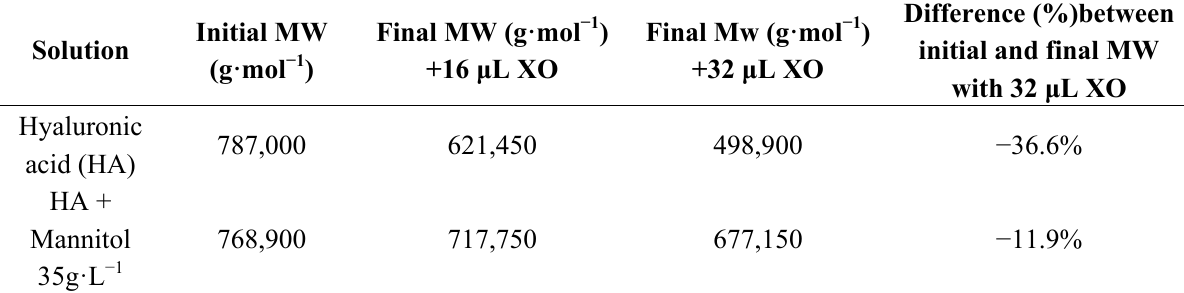
Table 1. Weight-average molecular weight (MW in g·mol − 1 ) of hyaluronic acid alone and in presence of mannitol (35g·L − 1 ) before and after exposure to an oxidative stress induced by xanthine/xanthine oxidase (X/XO) at increasing doses added in 4mL HA solution.